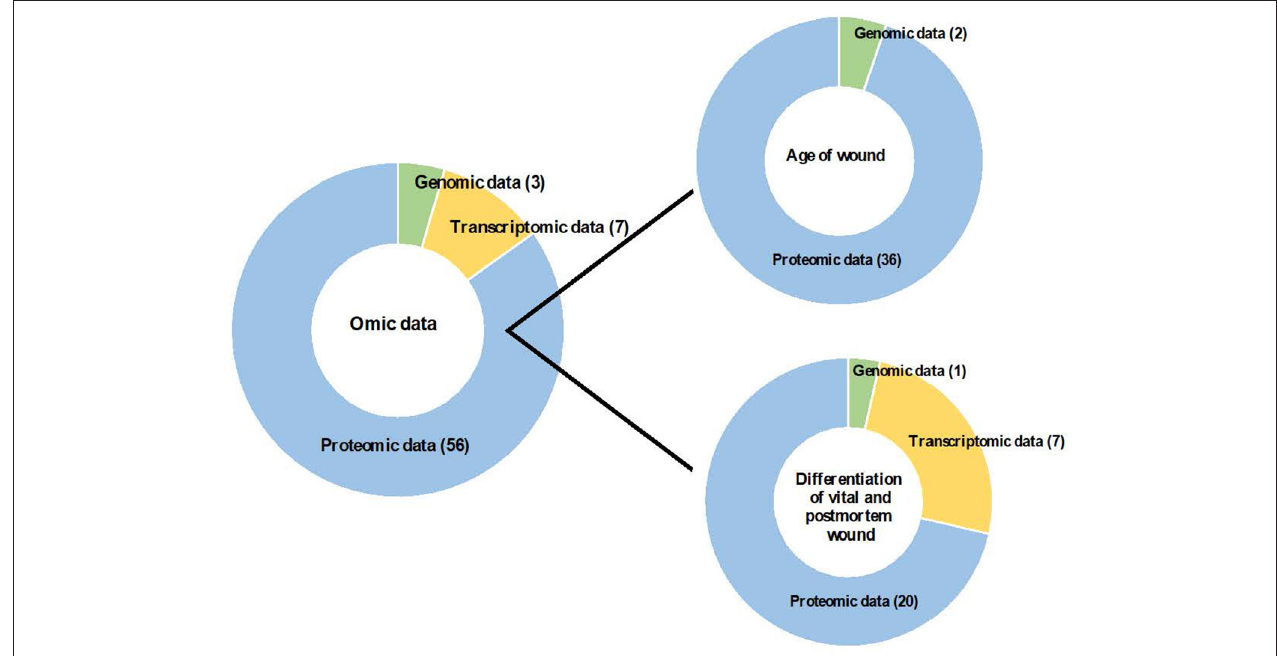
FIGURE 2 | Contribution of omic sciences to the study of age of wound and differentiation of vital and post-mortem wound.